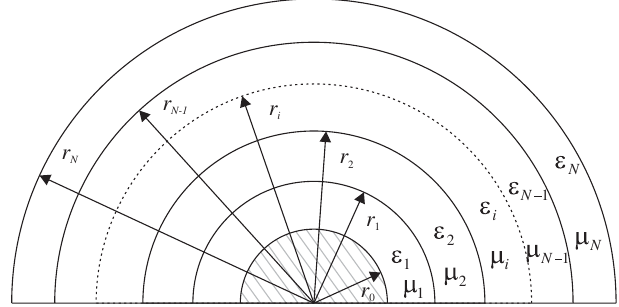
FIG. 2. Cross section of an N -zone dielectric-lined coaxial waveguide structure. The innermost vacuum zone of radius r o is for transport of the accelerated